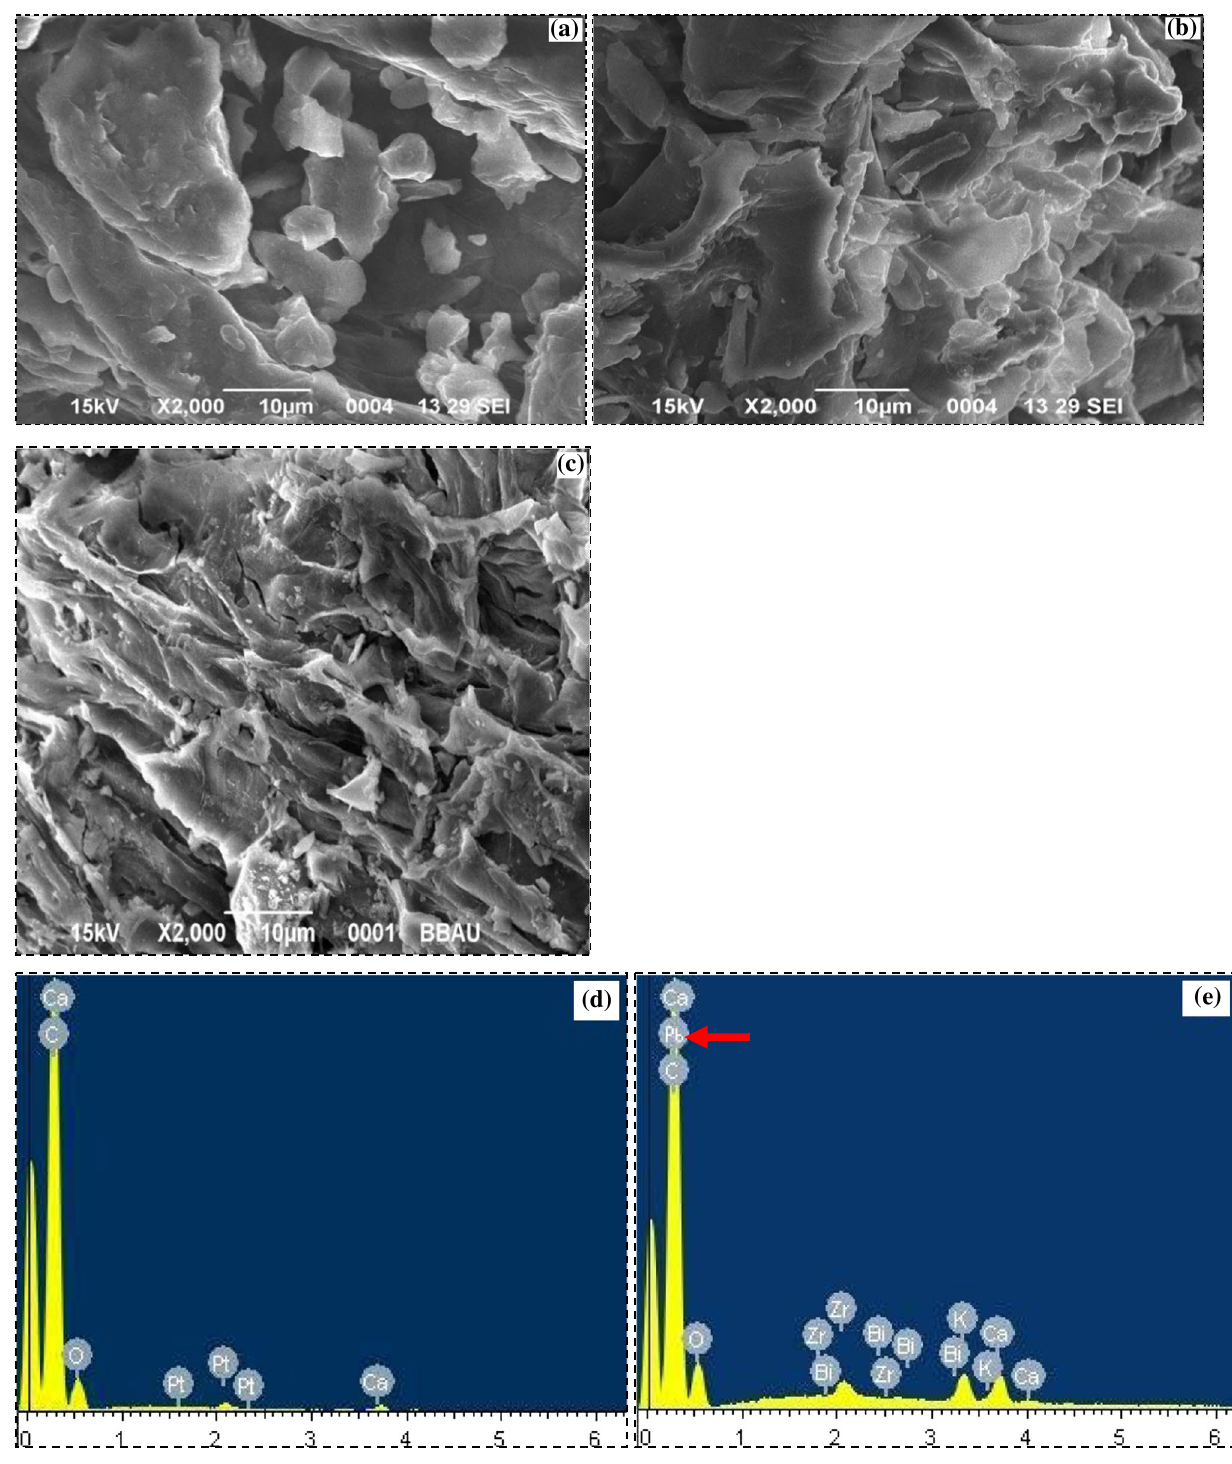
Fig. 2 SEM images of: a bagasse, b bagasse biochar, c lead (Pb 2+ )-loaded bagasse biochar; EDX spectrum of d bagasse biochar and e